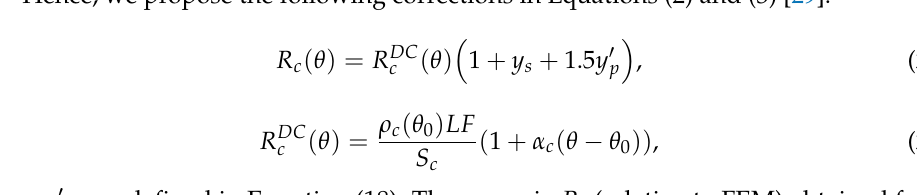
Figure 12. Variations in the ( a ) losses and ( b ) current density distribution in conductors of Cable 6 when a magnetic armor of µ r = 300 − j 200 is installed (SB).